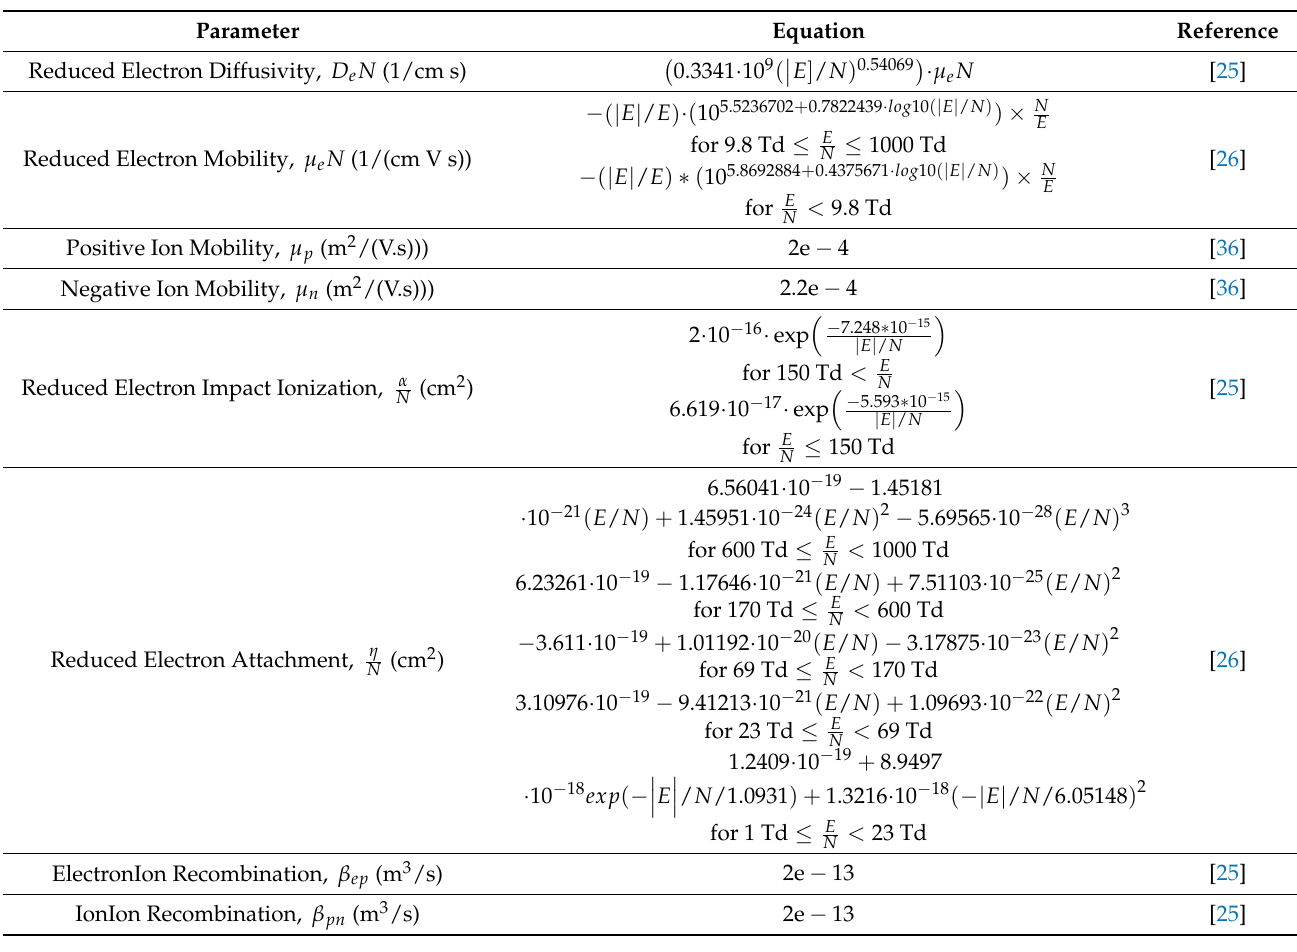
Table A4. Swarm Parameters.